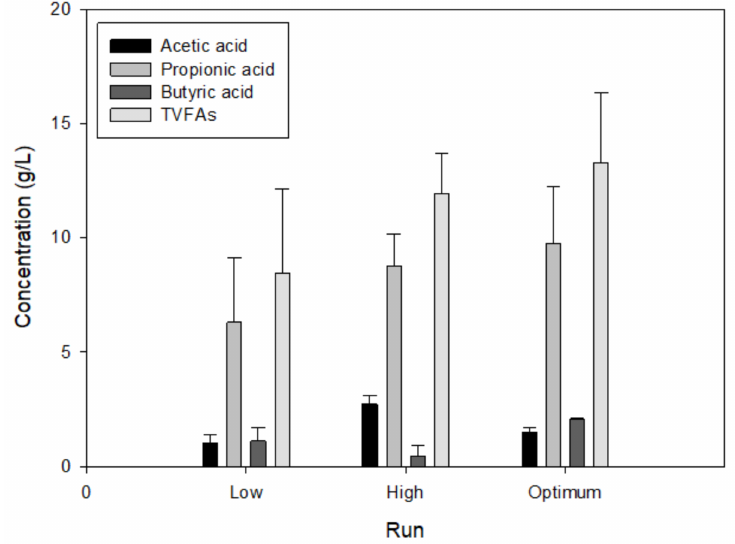
Figure 3. VFA production from a codigestion of crude glycerol with algal biomass at the initial pH of 6 under low (10 g/L of glycerol, 6.17% of inoculum, and 4.62 g-VS/L of algal biomass), high (40 g/L of glycerol, 25% of inoculum, and 23.1 g-VS/L of algal biomass), and optimal (13.83 g/L of glycerol, 10.31% of inoculum, and 23.1 g-VS/L of algal biomass) conditions. TVFA: total volatile fatty